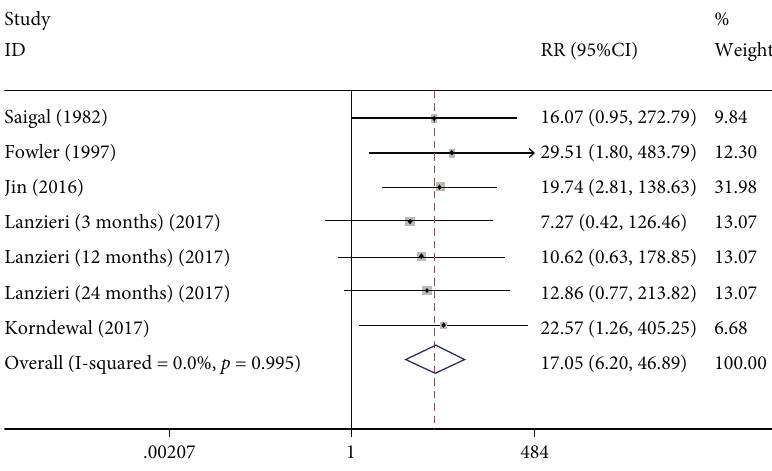
Figure 3: The forest plots of SNHL between CMV group and control group.